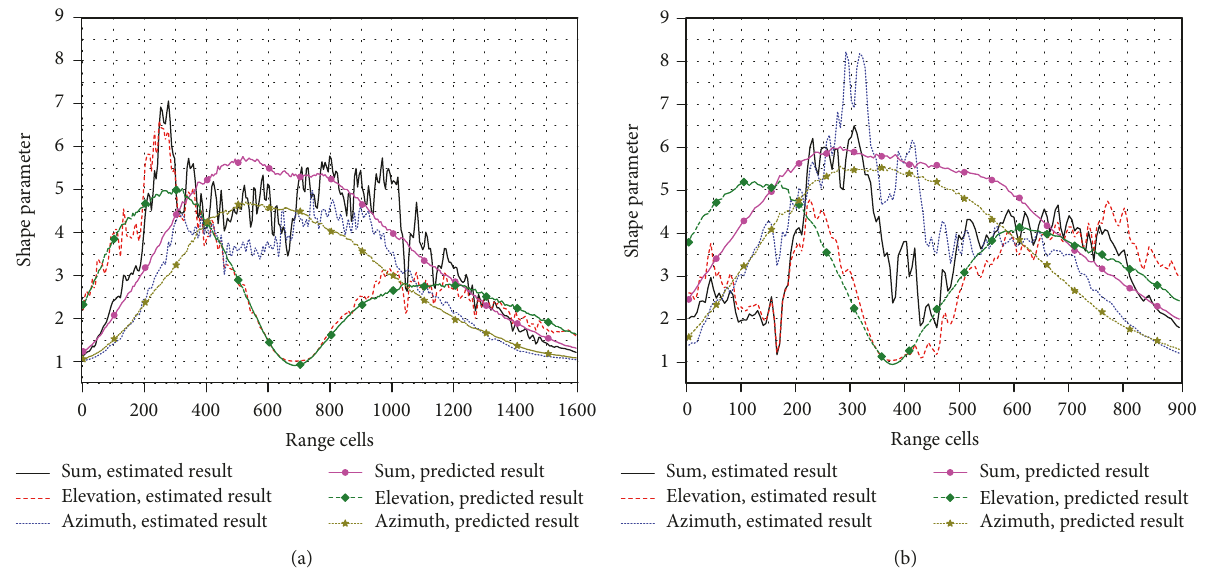
Figure 6: Estimated and fitted 𝐾 distribution shape parameter, where the thermal noise is considered: (a) DS1. (b)